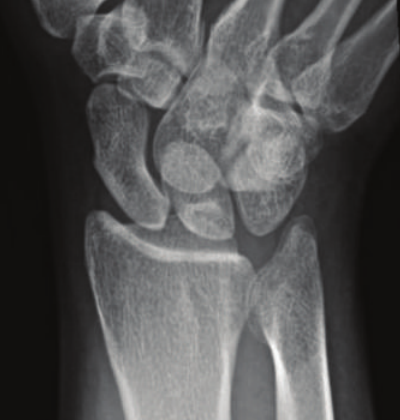
Figure 5: A scaphoid view obtained 6 weeks after presentation without radiographic evidence of a scaphoid waist fracture.